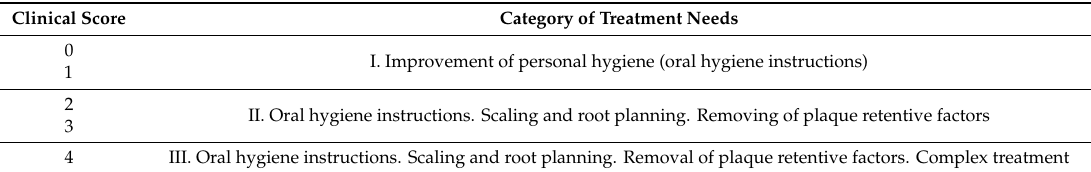
Table 1. Category of treatment